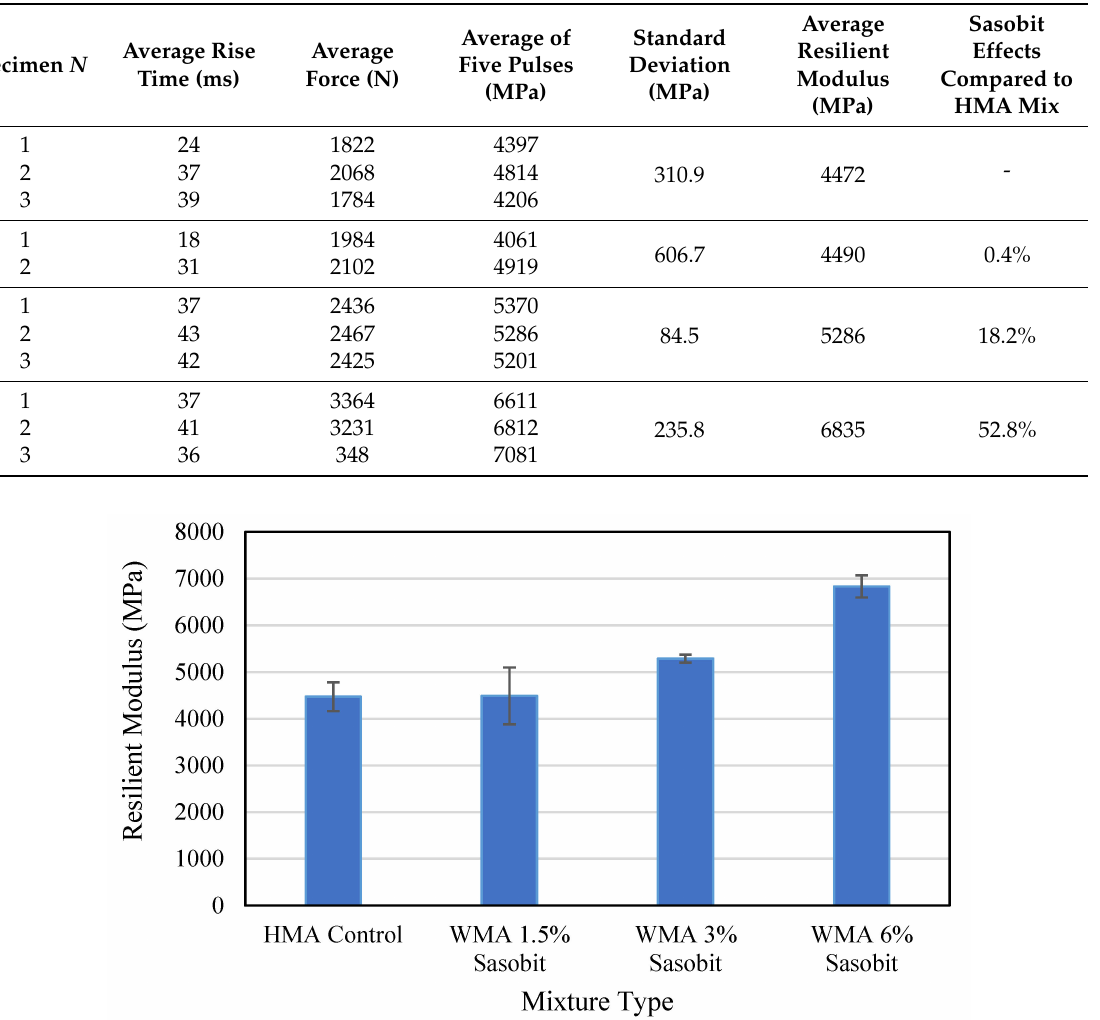
Table 5. Average resilient modulus results.